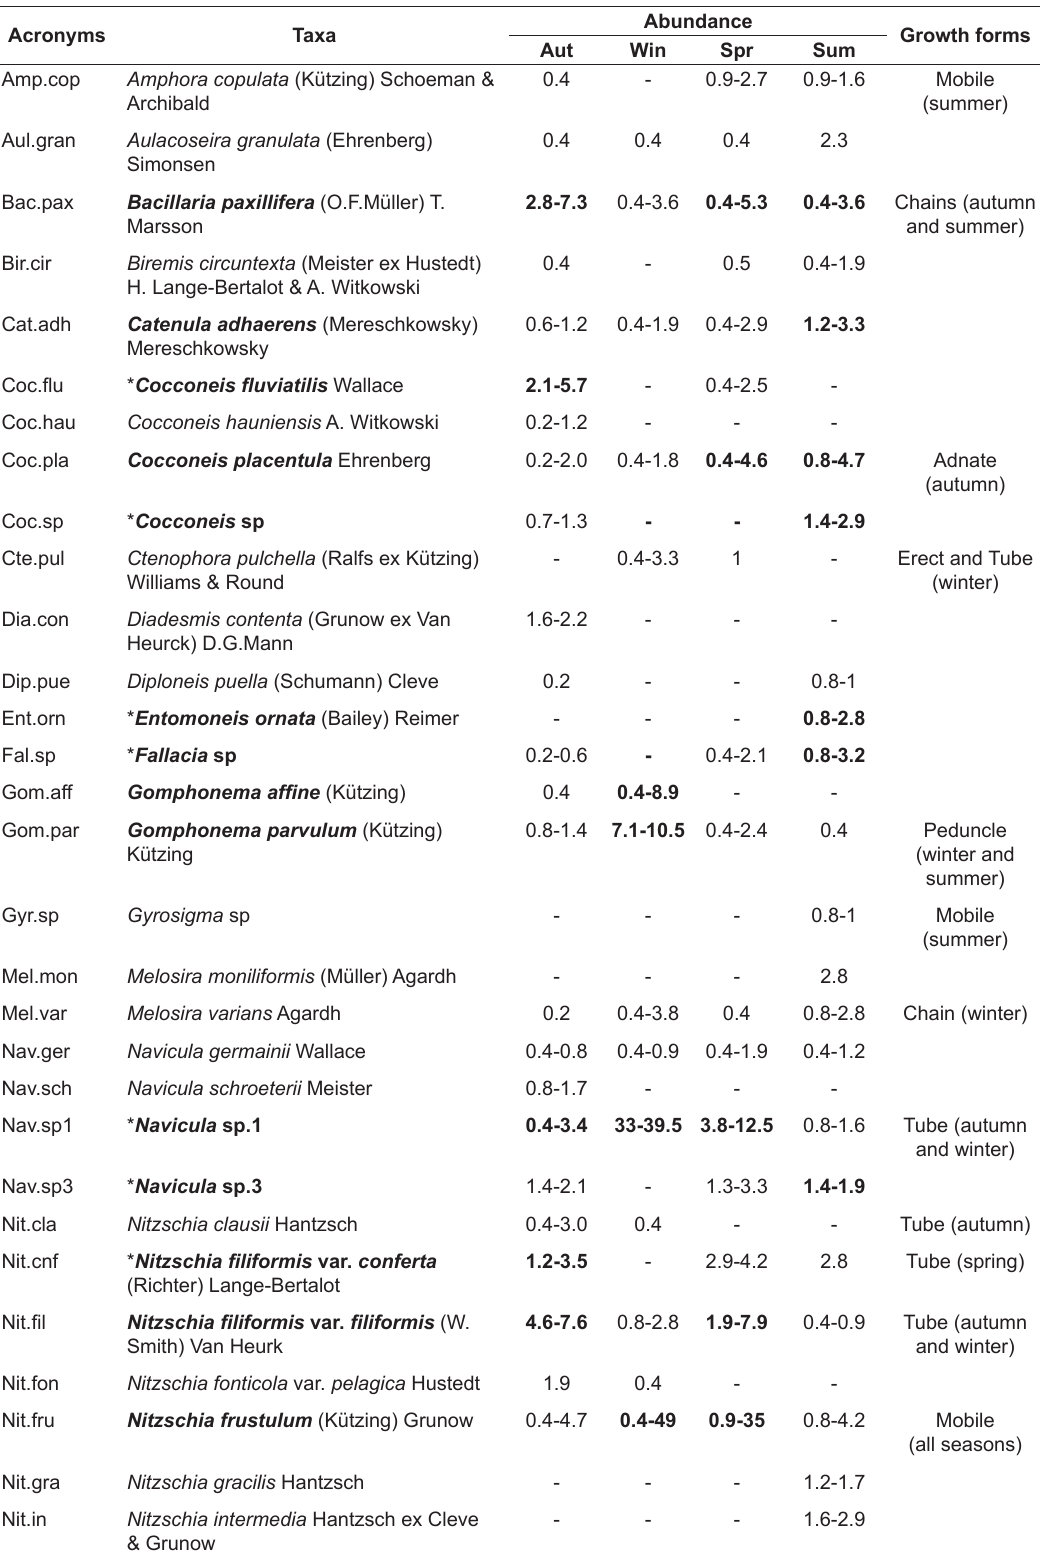
Table 1. List of taxa that were used in the canonical correspondence analysis (with abundance ˃ 1% and acronyms) including 25 abundant species (bold), and 21 growth